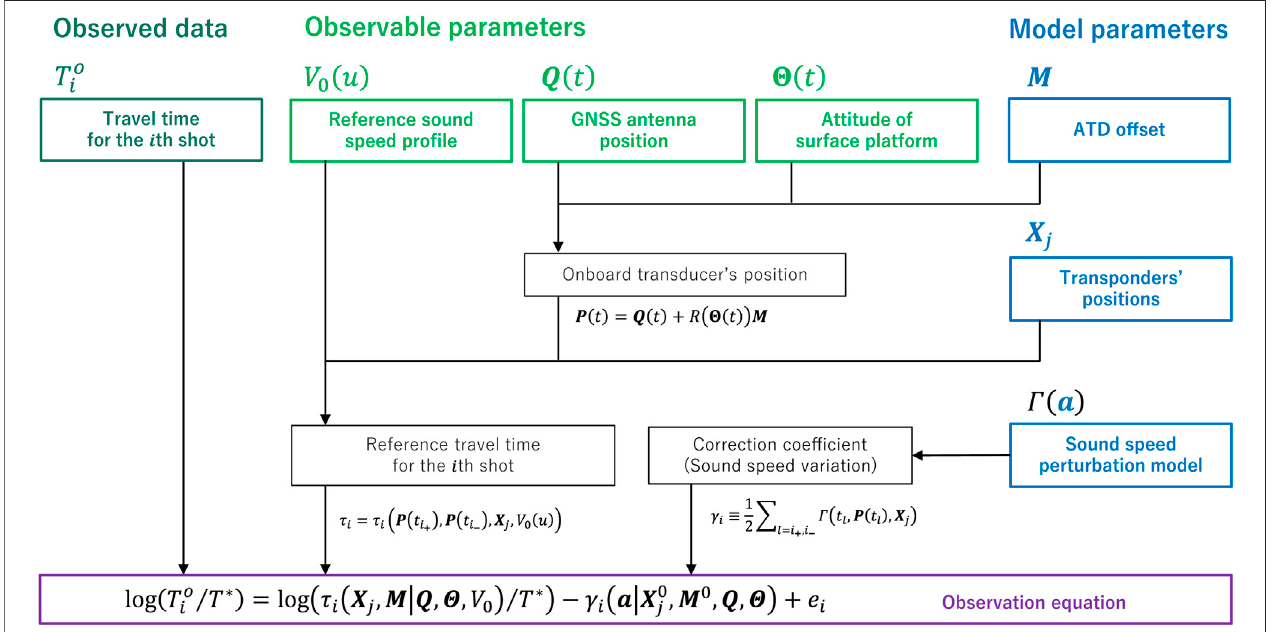
FIGURE 3 | Flow chart to construct the observation